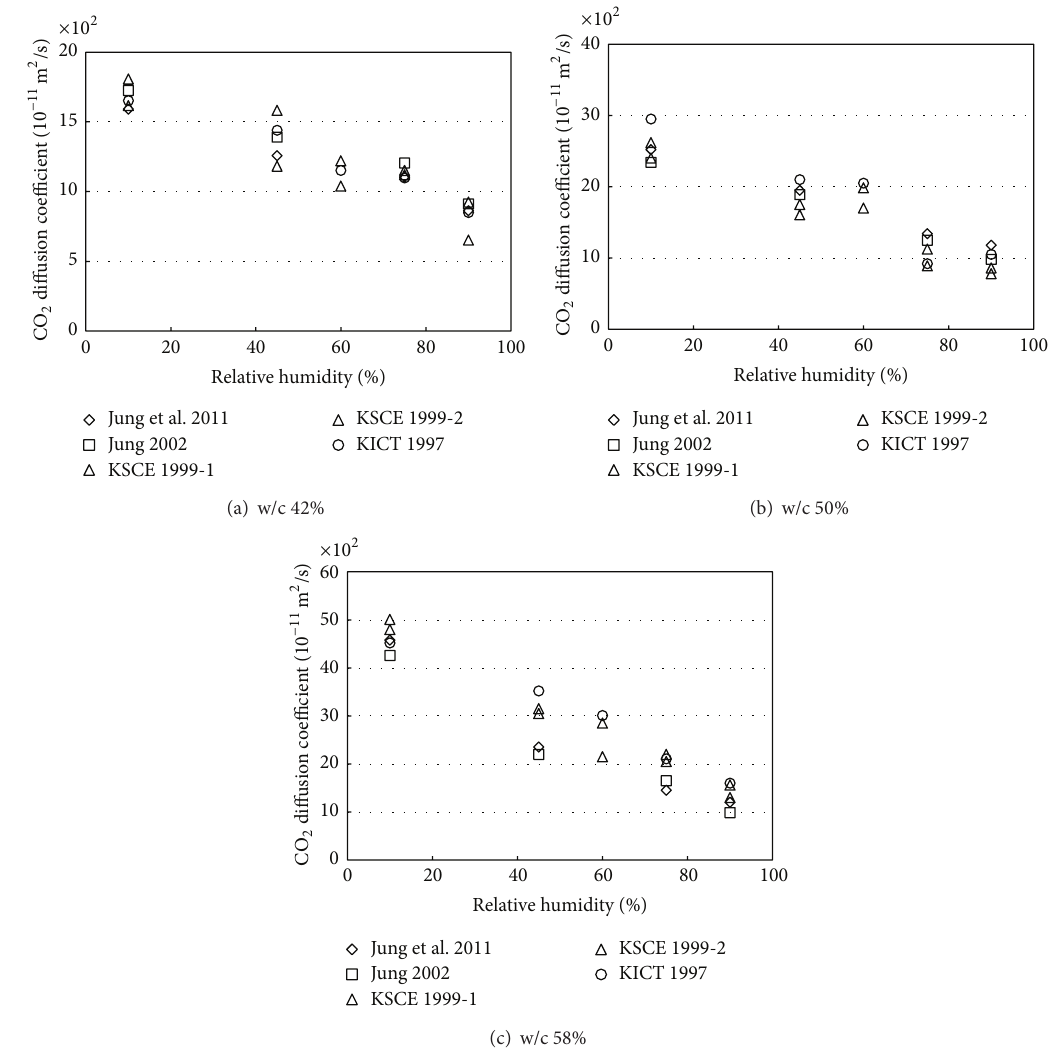
Figure 3: CO 2 diffusion coefficients with w/c ratios and R.H.